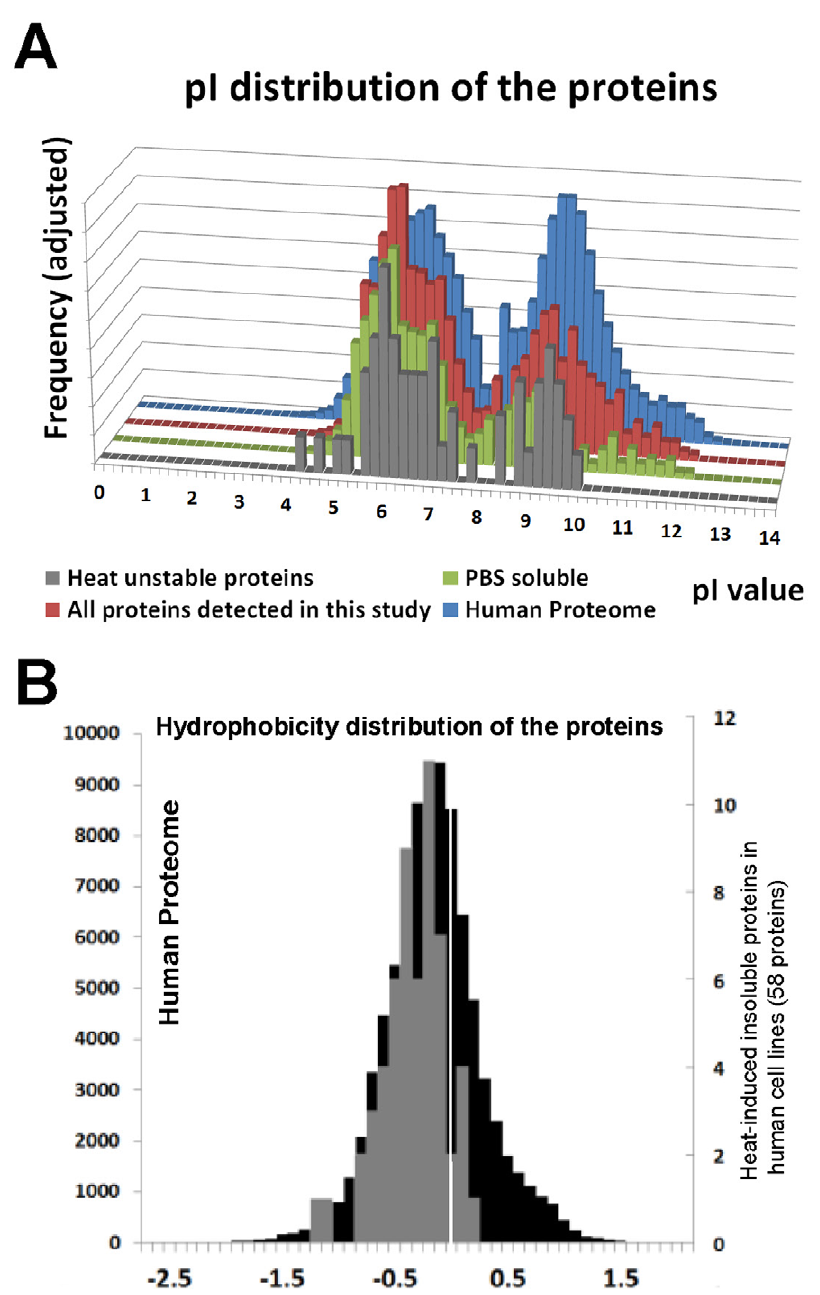
Figure 6. Comparisons of physiochemical characteristics of the proteins identified to be insoluble after heat-shock treatment in SH- SY5Y and CCF-STTG1 cell lines. (A) Protein theoretical isoelectric point (pI), and (B) hydrophobicity, between the heat-shock induced insoluble proteins identified from this study with the whole human proteome. For pIs, all the proteins identified in LC-MS/MS data in any fraction and all the soluble proteins identified in LC-MS/MS data were also included in comparison. Predicted pI values were obtained from the IPI human protein database (version 3.72) and the pI distribution was plotted with 0.2 pH unit increments. Hydrophobicity values (Kyte-Doolittle scale, the white mid- line is 0.) were also obtained from the same database and were plotted with 0.1 unit increment. In (B) the black bars graph data from the whole proteome and the gray bars graph data from the insoluble proteins of the heat-shocked cells.